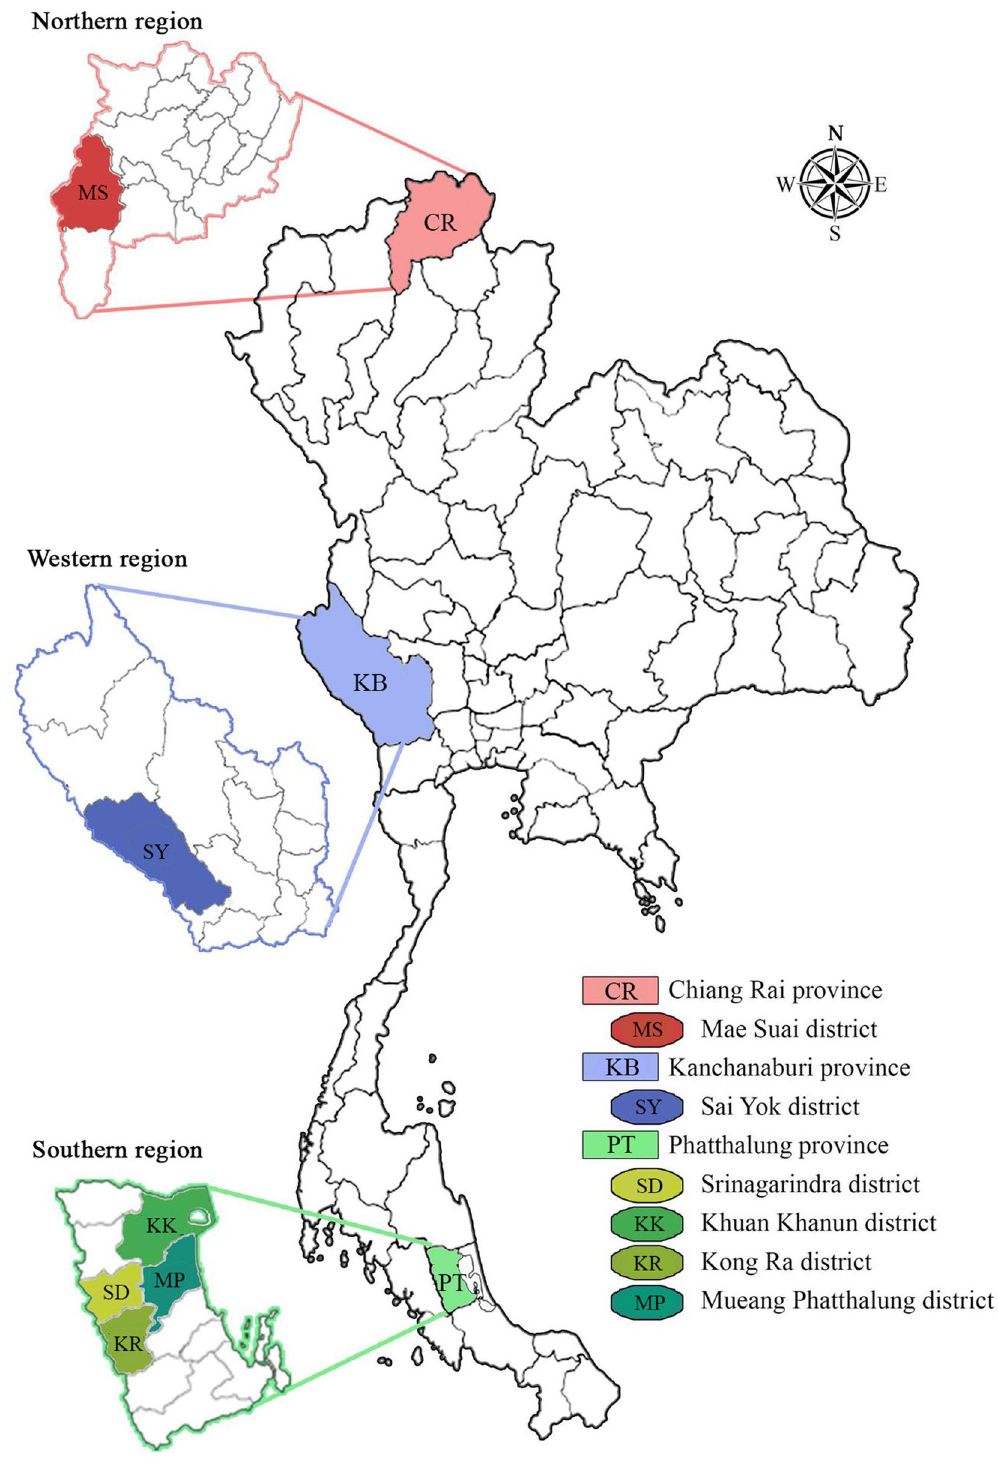
Figure 5. Geographical location of northern, western and southern regions where chicken blood samples are collected and examined. Legends indicate the distribution of Leucocytozoon sabrazesi Thailand strains discriminated in chickens from Mae Suai district (MS) in Chiang Rai province (CR), Sai Yok district (SY) in Kanchanaburi province (KB) and Srinagarindra (SD), Khuan Khanun (KK), Kong Ra (KR) and Mueang Phatthalung (MP) districts in Phatthalung province